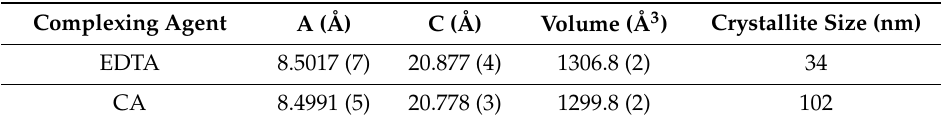
Table 1. The calculated lattice parameters from the Le-bail fitted XRD patterns obtained from the sol–gel prepared samples with two di ff erent complexing